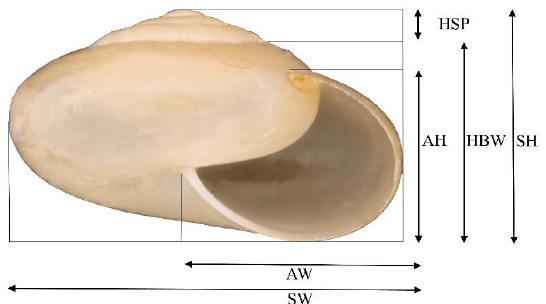
Figure 1. Shell measurements used for characterizing Macrochlamys indica . Abbreviations: SH, shell height; SW, shell width, AH, aperture height; AW, aperture width; HSP, height of spire, and HBW, height of the body whorl.